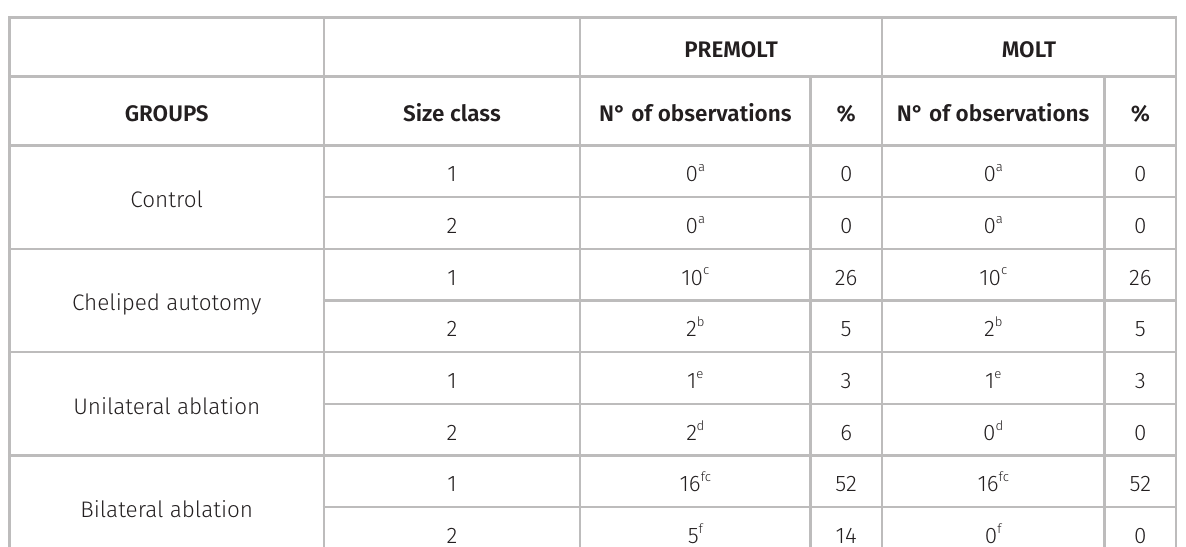
Table II. Premolt and molt frequencies in Callinectes ornatus of different size classes subjected to different experimental